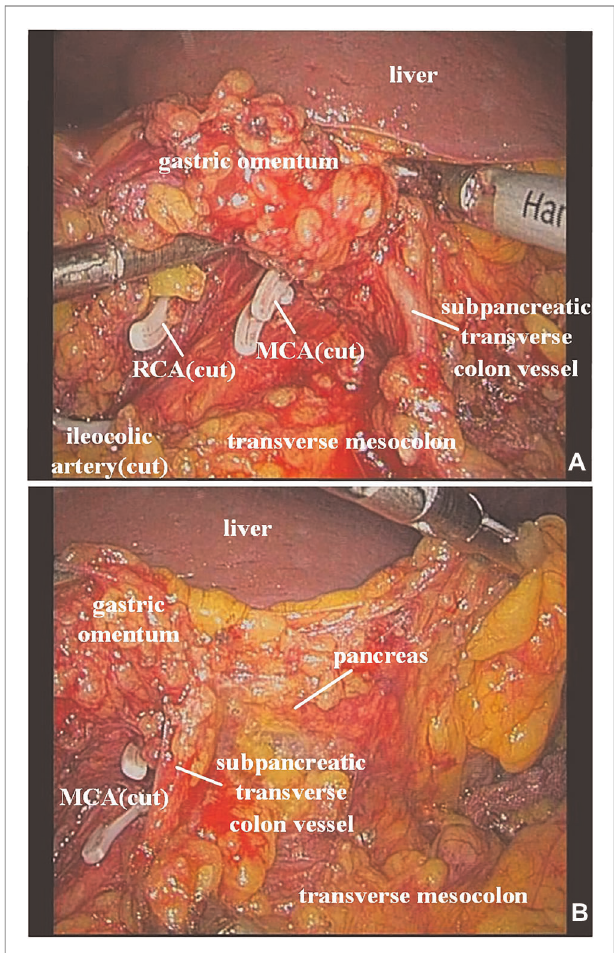
FIGURE 3 | ( A ) It was observed that the ileocolic artery, RCA, and MCAwere severed, and a thickened subpancreatic transverse colon vessel is naked. ( B ) The thickened subpancreatic transverse colon vessel emanated from the inferior margin of the pancreas, and supplied the transverse colon. RCA, right colic artery; MCA, middle colic artery.